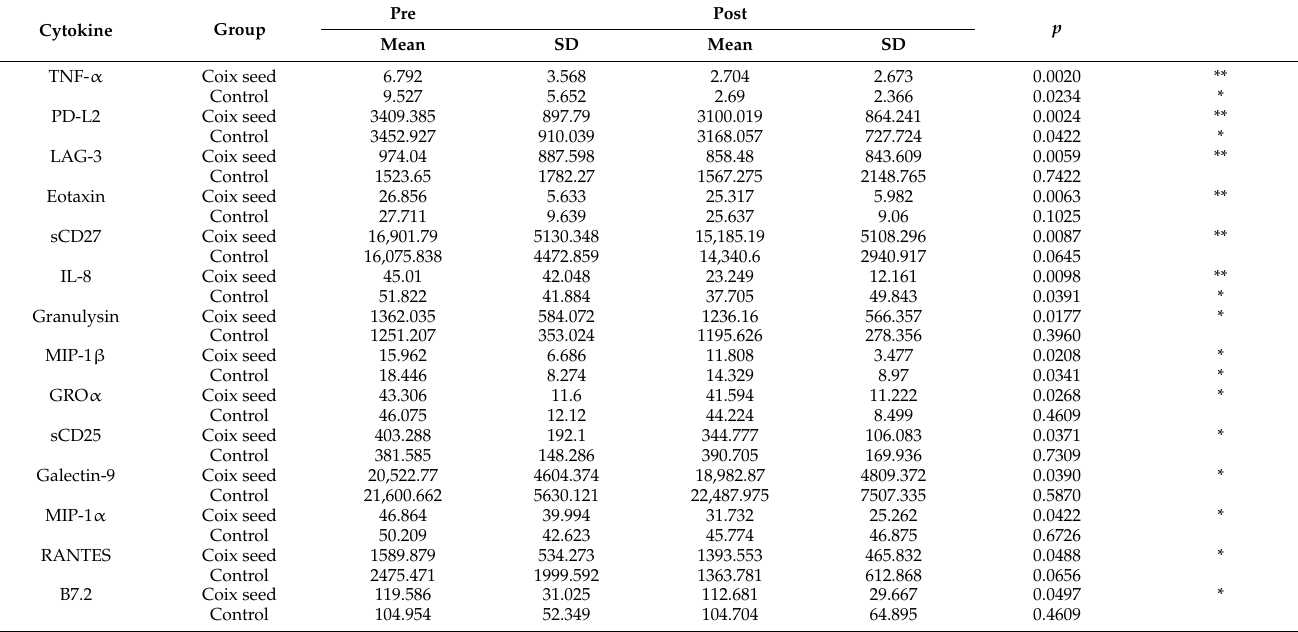
Table 1. Plasma cytokines that showed significant changes after coix seed consumption.